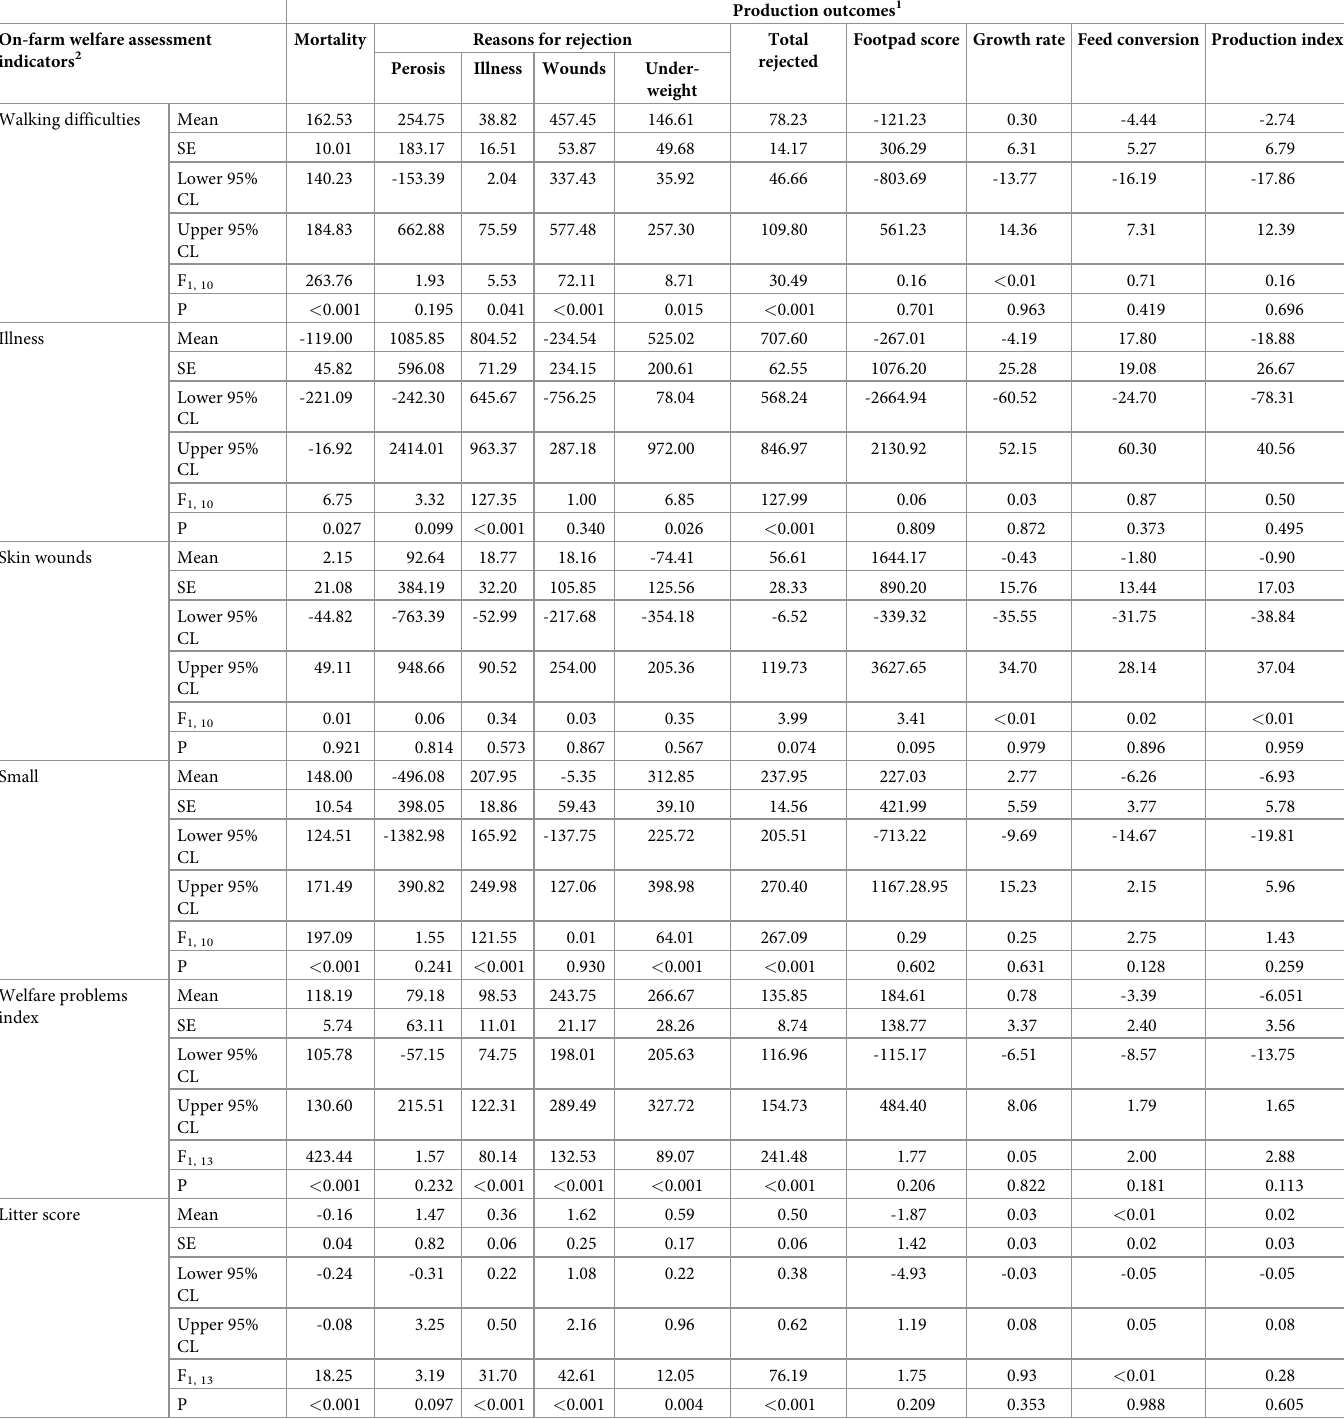
Table 6. Regression coefficient estimates for relationships between welfare problems detected by transect sampling, and production